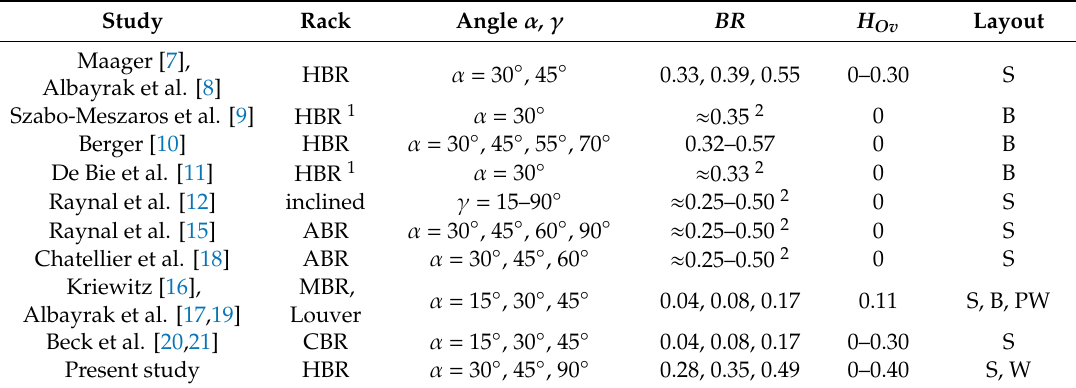
Table 2. Overview of laboratory studies investigating velocity fields at